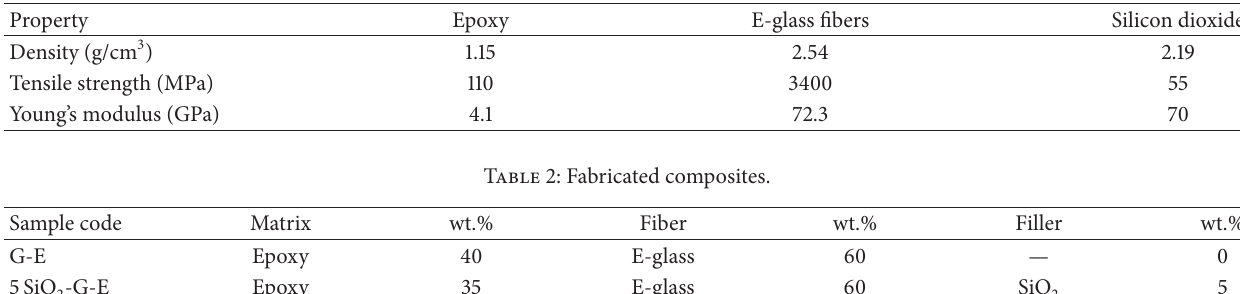
Table 1: Properties of epoxy, E-glass fiber, and silicon dioxide.